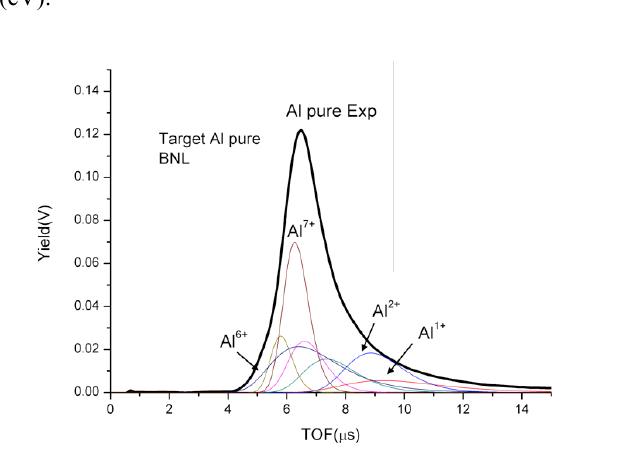
Fig. 4. Result of deconvolution on Al pure target using CBS function.